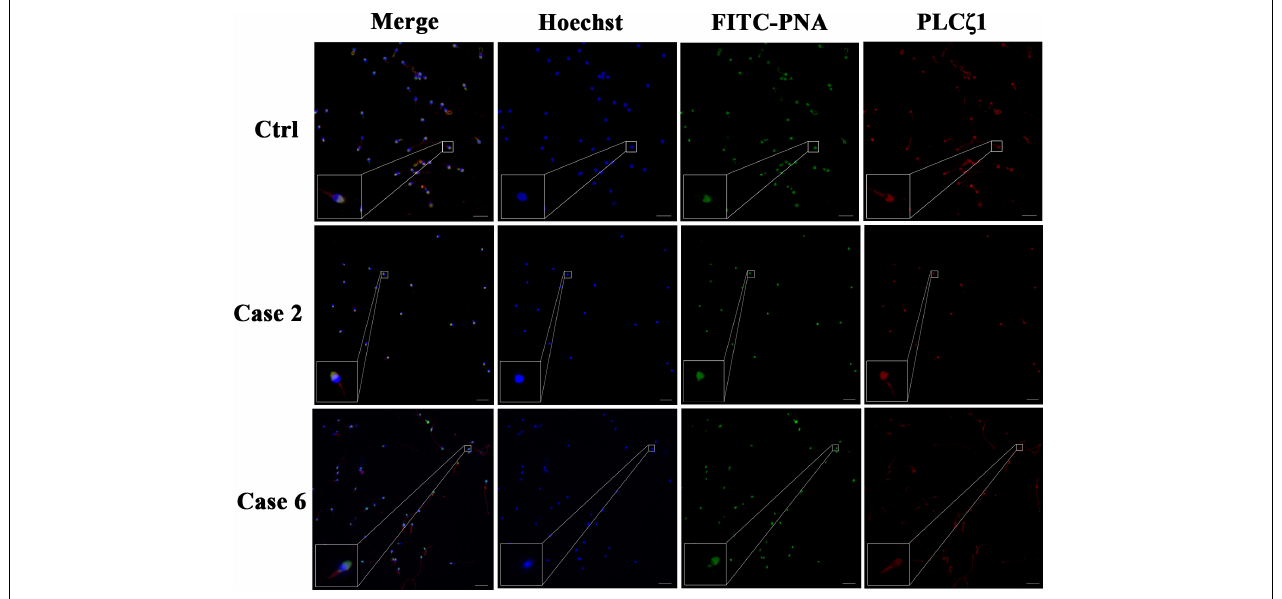
FIGURE 1 | Detection of PLC ζ 1 expression in cases with TFF after conventional AOA. In the case of the normal male control, the signals of PLC ζ 1 (labeled by Cy3, red) overlapped with the outer acrosomal membrane marker PNA (labeled by FITC, green) almost completely. The localization and morphology of PLC ζ 1 and PNA in Cases 2 and 6 were in accordance with the normal control. The nuclei of the sperms were stained by Hoechst-33342 (blue). Scale bars = 50 µ m.